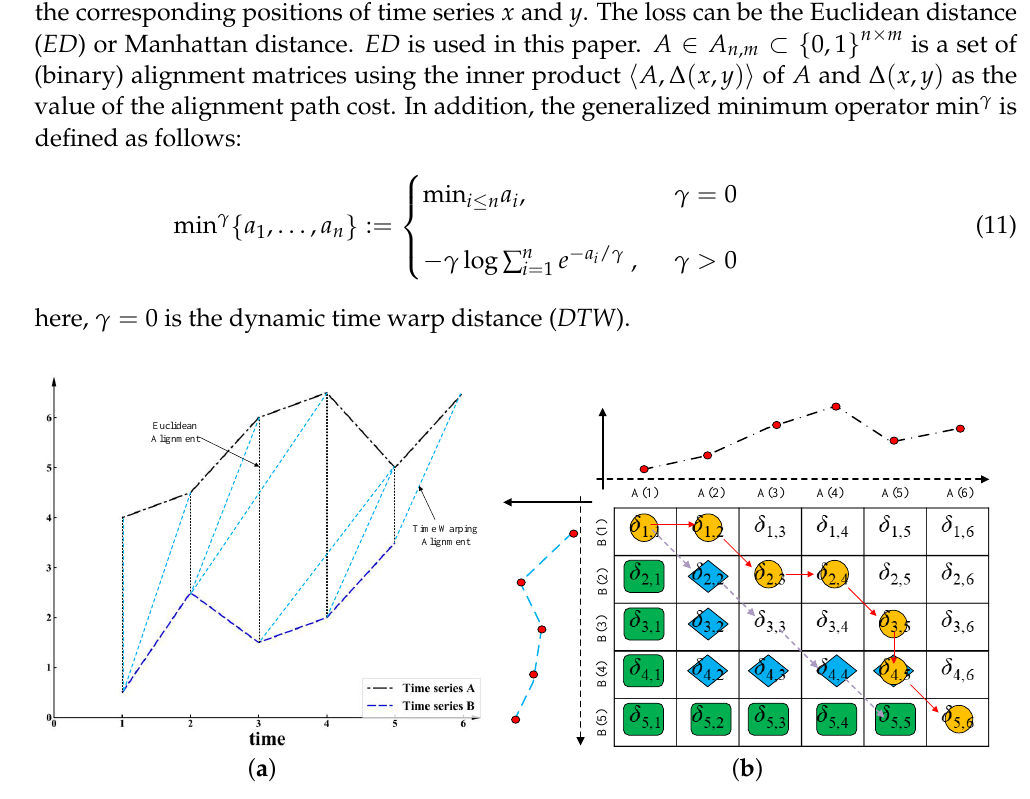
Figure 9. Different alignments and losses for two one-dimensional time series: ( a ) Euclidean align- ment and time warping alignment; ( b ) different alignment matrices between two time series of lengths 6 and 5, respectively, where the paths include orange, green, blue,